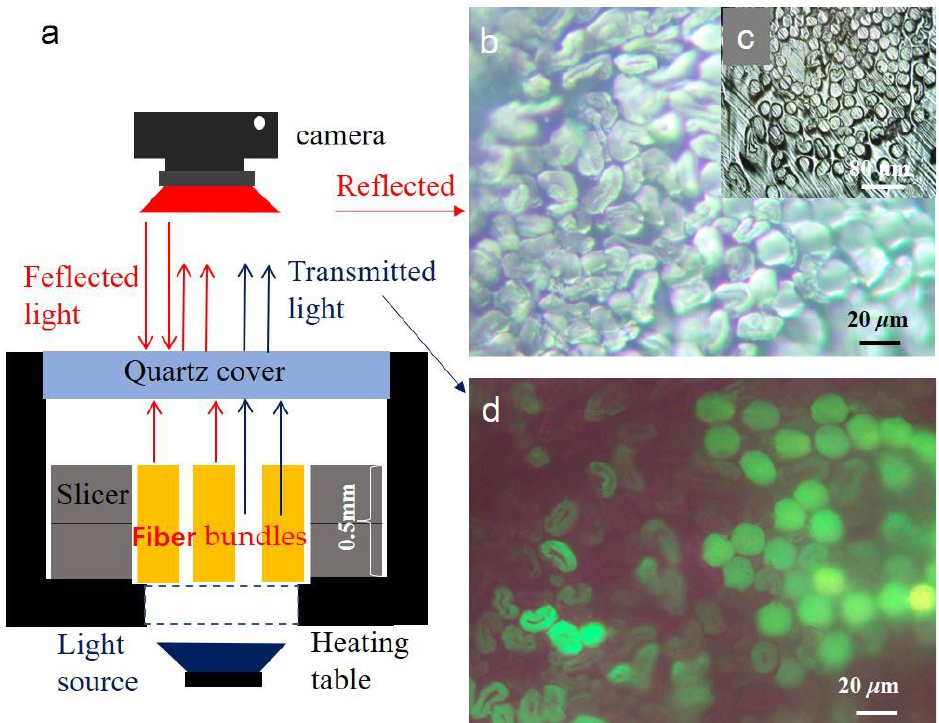
Figure 1. Transmission and reflection observation diagram of the cross-section of polyester/cotton blended fibers ( a ) test schematic illustration, ( b ) reflection observation diagram of polyester/cotton blended fiber non-embedded short fiber bundles, ( c ) reflection observation diagram of polyester/cotton blended fibers embedded slice, ( d ) transmission observation diagram of polyester/cotton blended fibers non-embedded short fiber bundles.